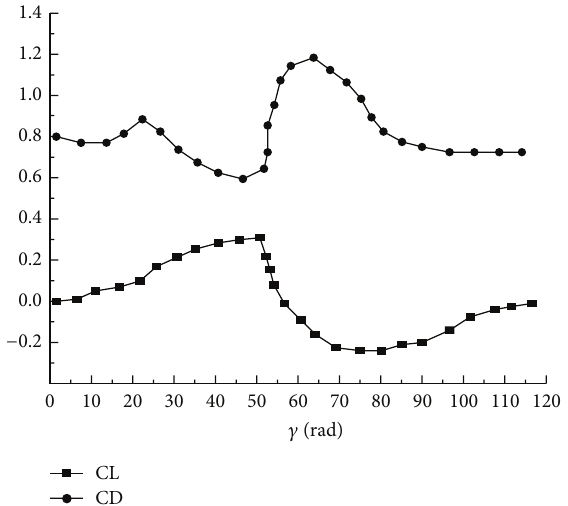
Figure 5: Aerodynamic coefficients versus the upper rivulet angle 𝛾 of the leeward conductor.